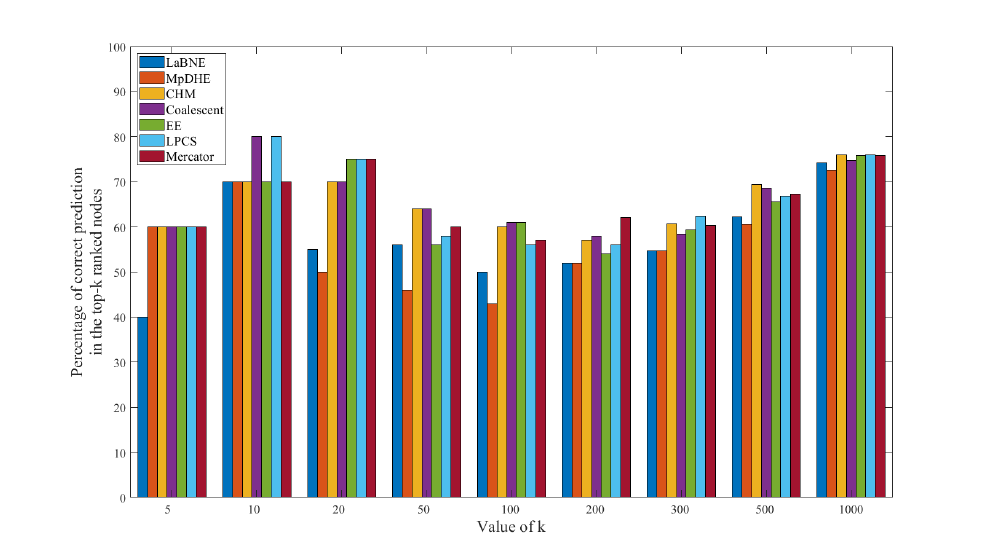
Figure 10. The proportion of correct predictions in top-k nodes on the DBLP